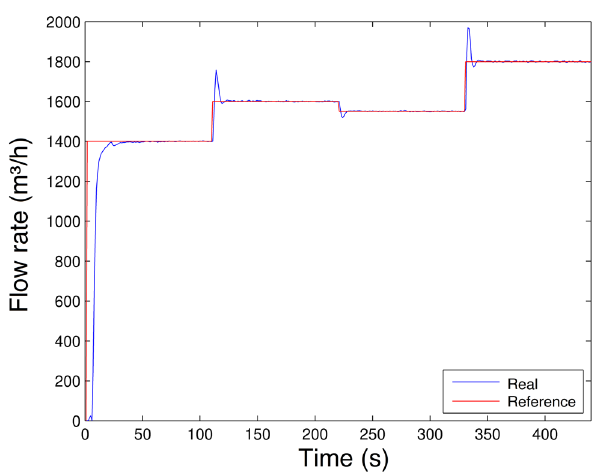
Figure 20. Flow rate control experiment Scenario